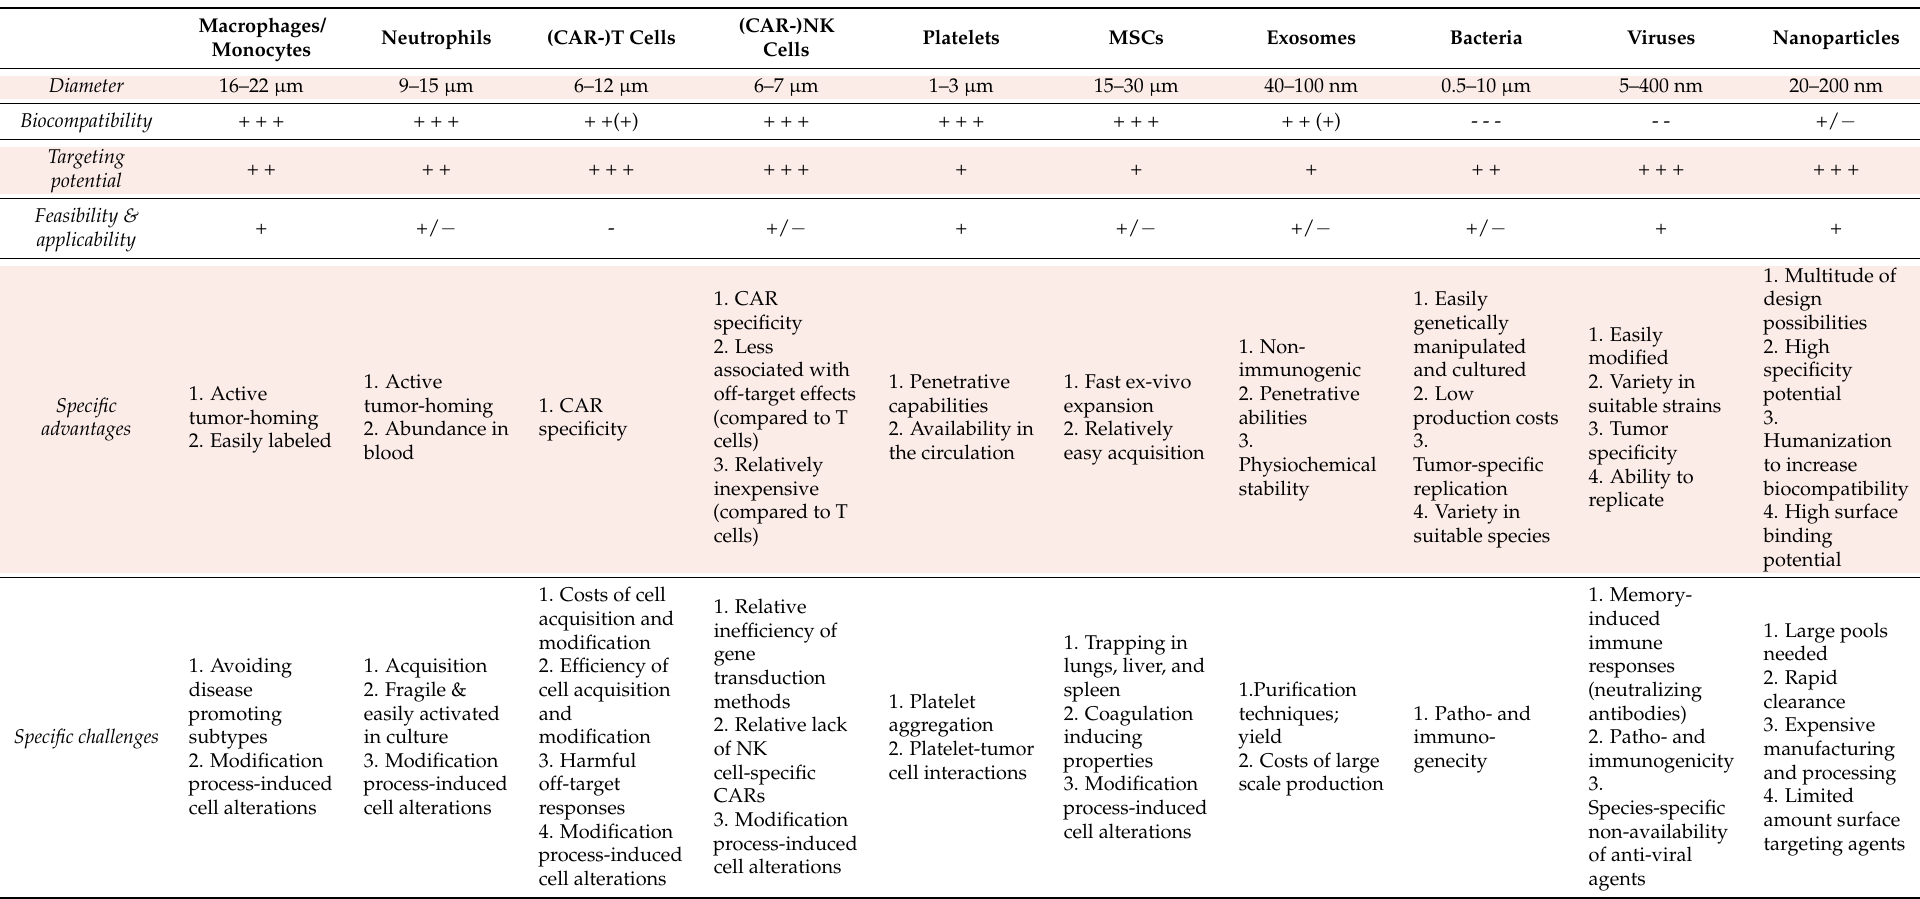
Table 1. Main characteristics, advantages, and disadvantages of cell- and nanoparticle-based tracers for image-guided